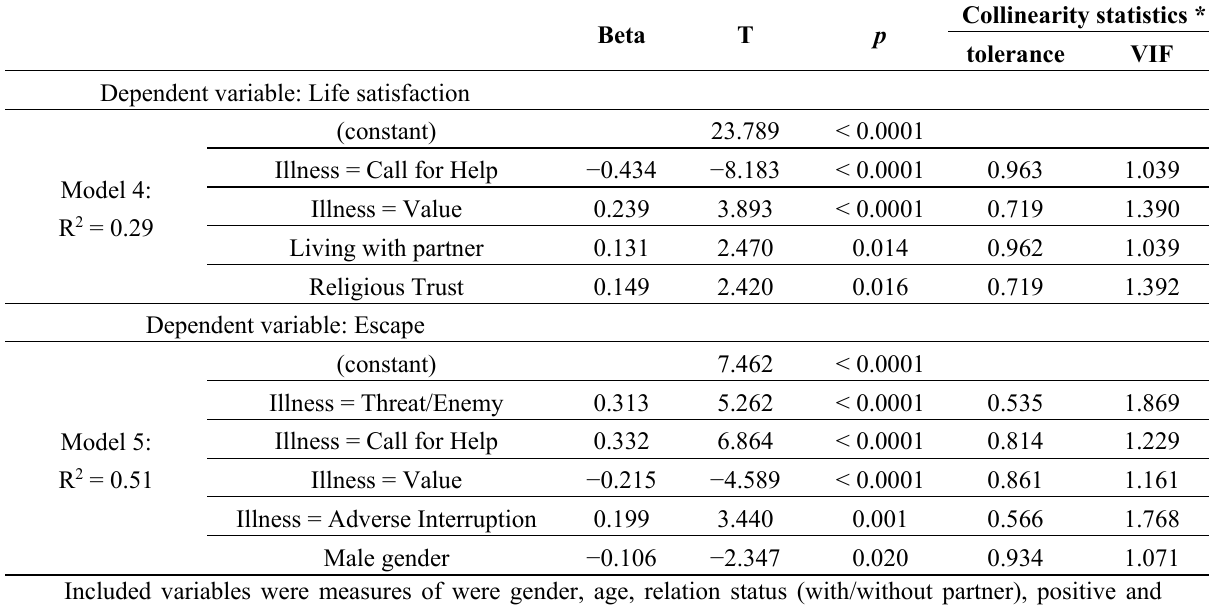
Table 7. Predictors of life satisfaction and escape from illness (stepwise regression